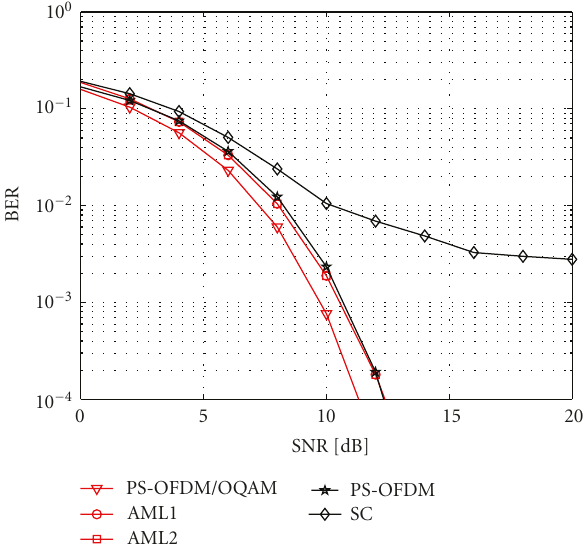
Figure 7: Performance of the considered CFO estimators as a function of the number of subcarriers in AWGN channel.